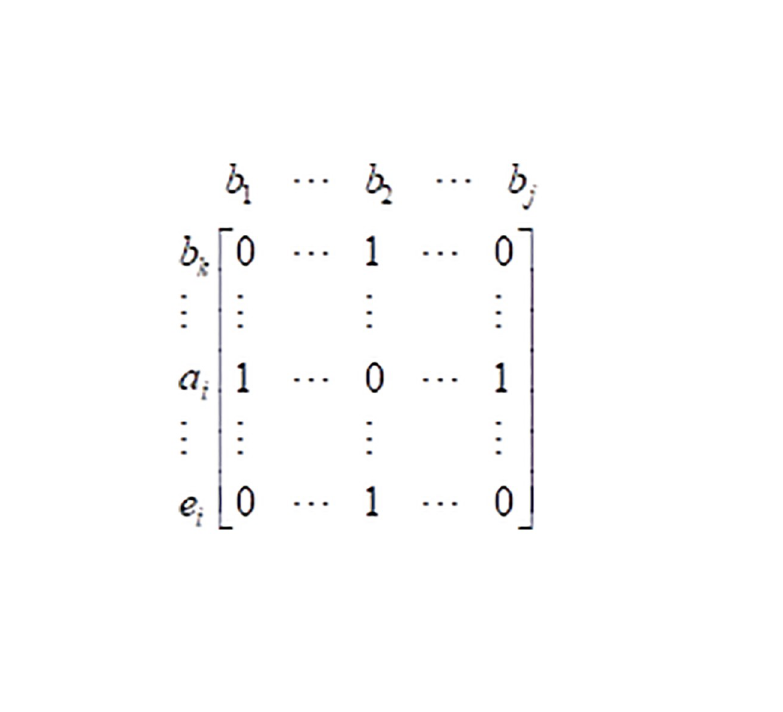
Fig 5. Two-dimensional binary antibody